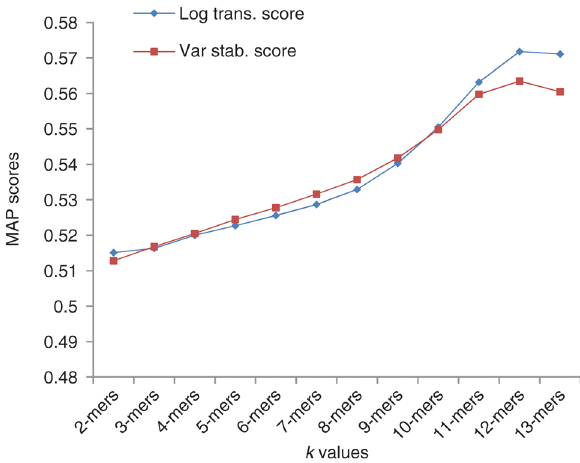
Figure 3: MAP scores of the Log transformed and Variance-stabilized Euclidean